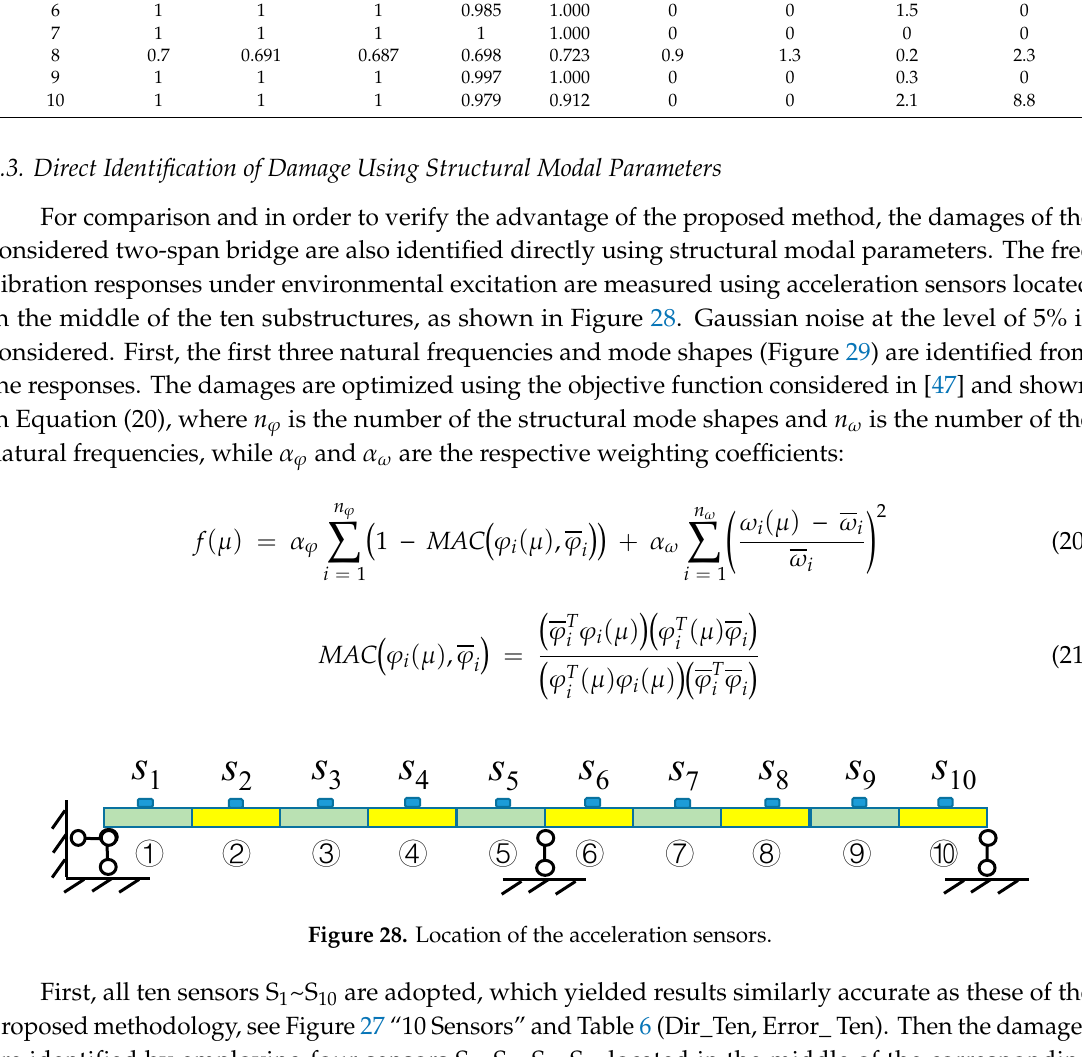
Figure 27. Comparison of damage identification results.